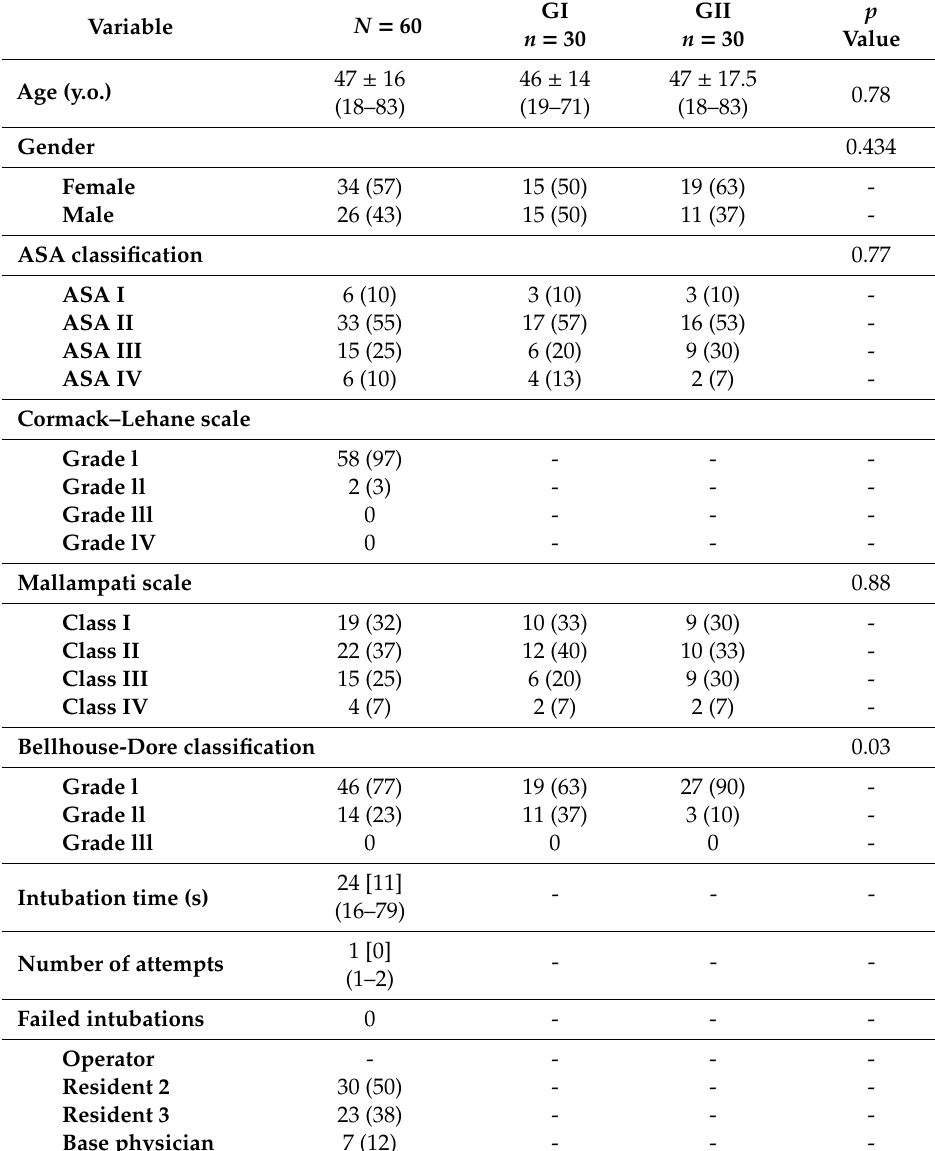
Table 2. Clinical characteristics of endotracheal intubation patients and variables studied with 232 in each device group (GI: VLG Hybrid 1.0; GII: VDL C-Mac shovel and